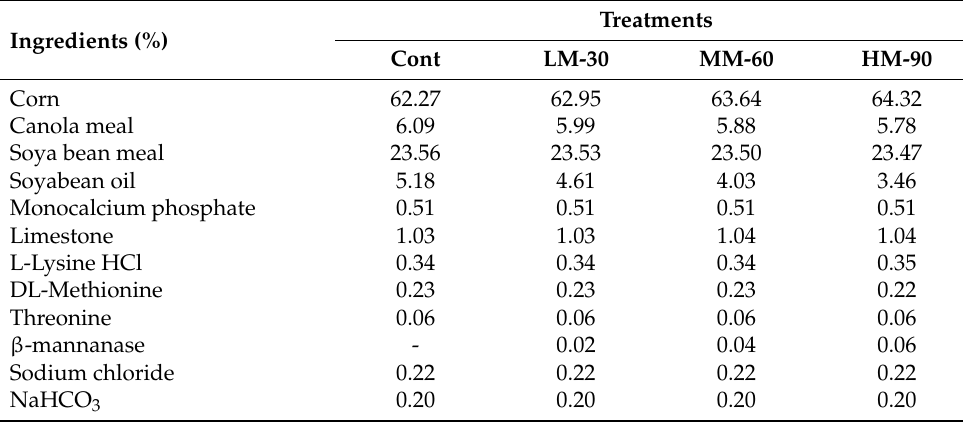
Table 3. Ingredient composition and nutrient profile of finisher feeds (22–35